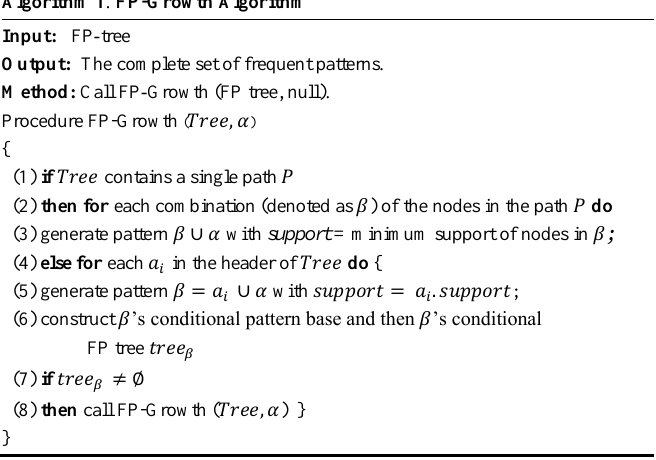
Algorithm 1 . FP-Growth